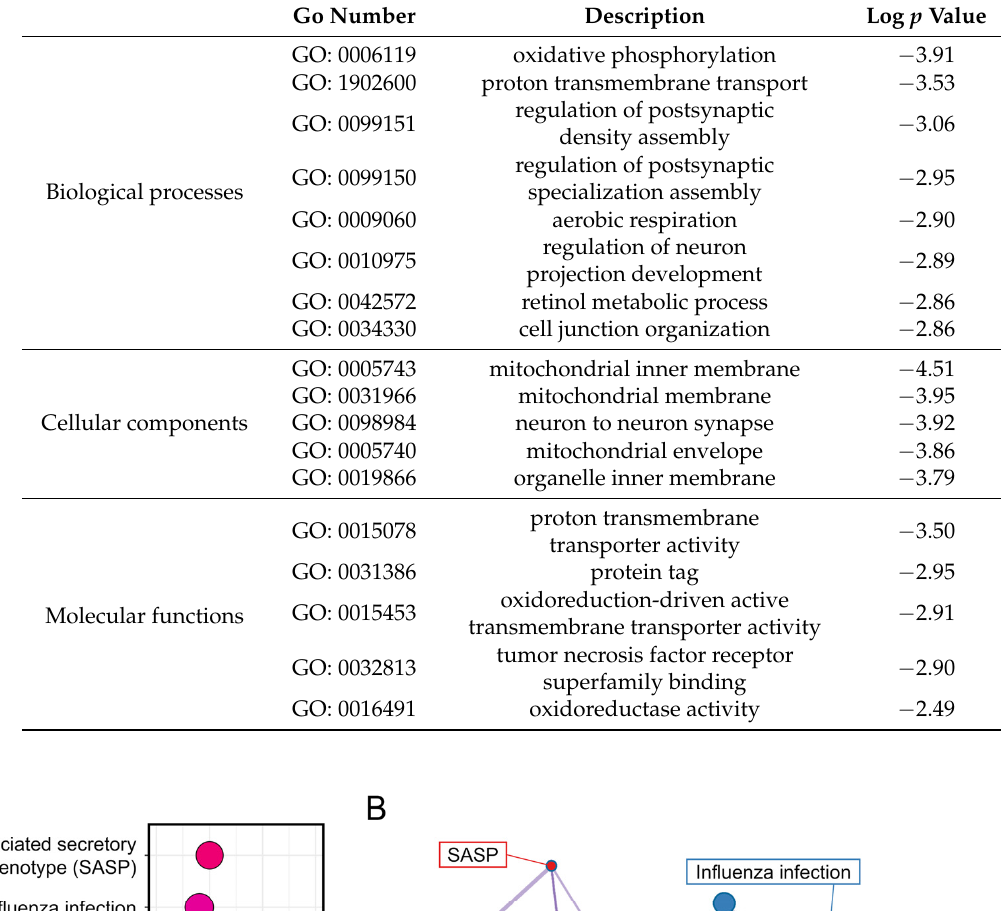
Table 2. Gene Ontology (GO) analysis of low-dose UVA-related differentially expressed genes.